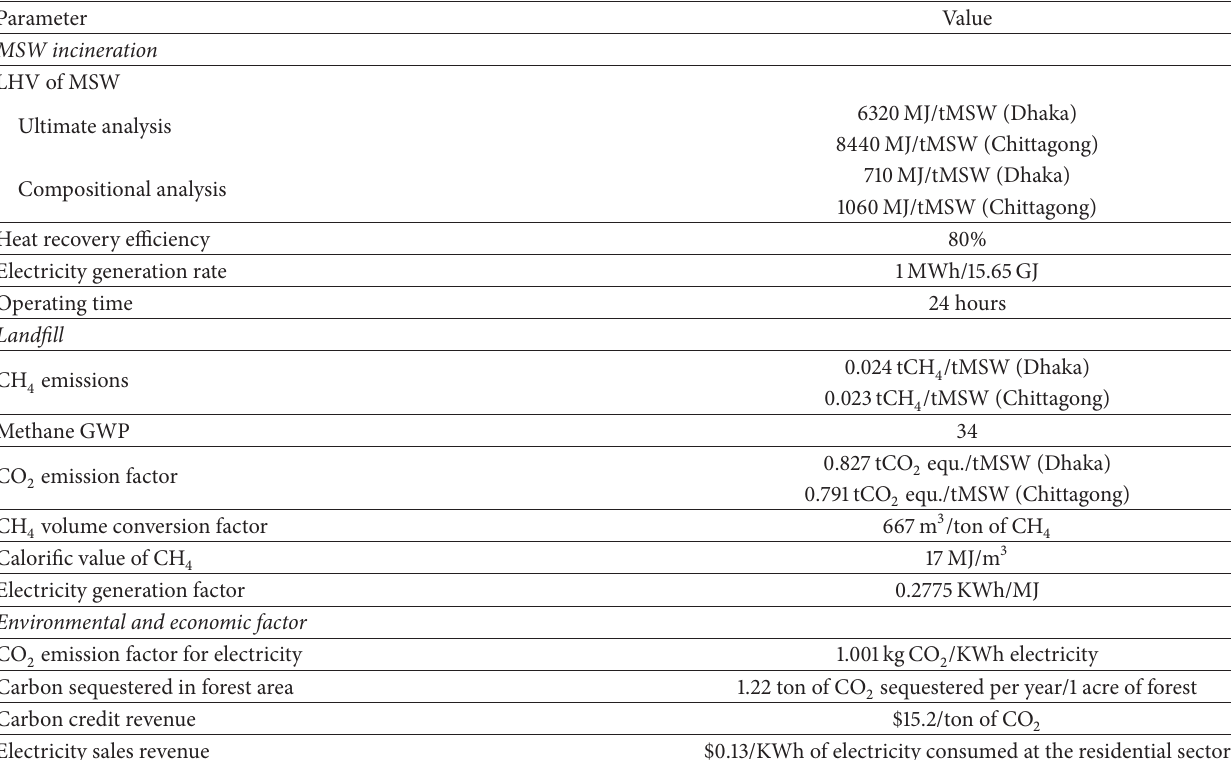
Figure 5: Actual and projected waste generation (a) and associated GHG emission (b) in Dhaka and Chittagong city. Actual wastes generation is from 2001 to 2015, and 2015 onwards represents projection. The legends of the figure are given at the bottom of (a) and (b). Table 7: WtE analysis parameter adopted for this